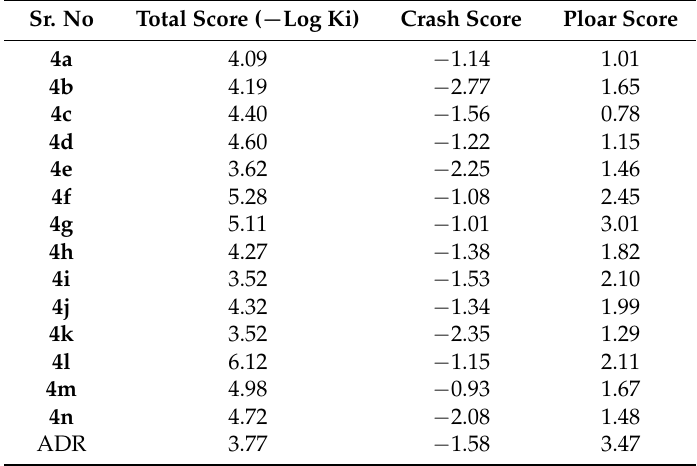
Table 4. Molecular docking of the synthesized compounds 4 ( a – n ) in tubulin receptor.